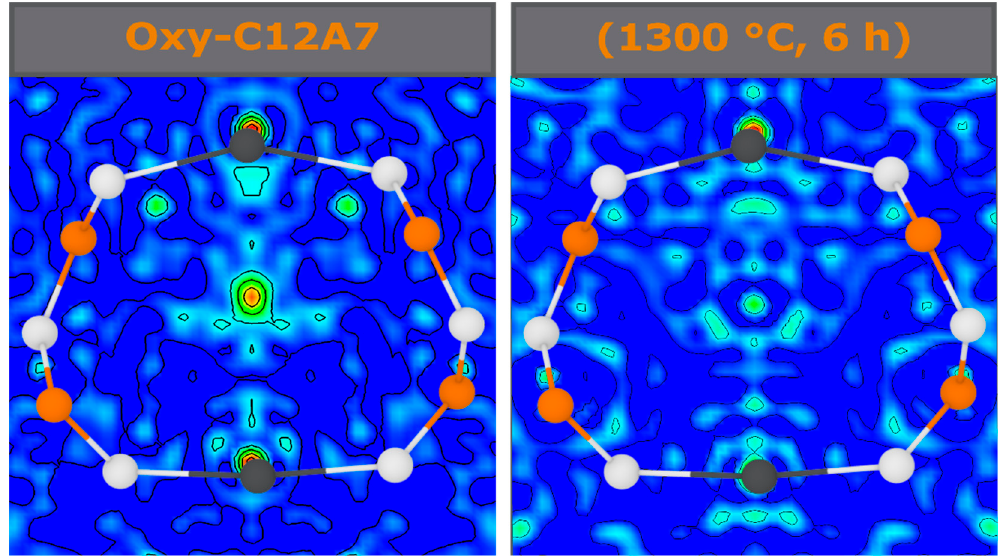
Figure 8. Fourier difference maps of the xy-plane at z = 0.25, slicing through the middle of a cage, generated from the synchrotron diffraction data. Brighter colors indicated an increase in scattering density with both Fourier maps having the same arbitrary scale. A comparison of as-synthesized oxy-C12A7 ( left ) and after processing for 6 h at 1300 °C ( right ). The contour lines are of consistent separation across samples.